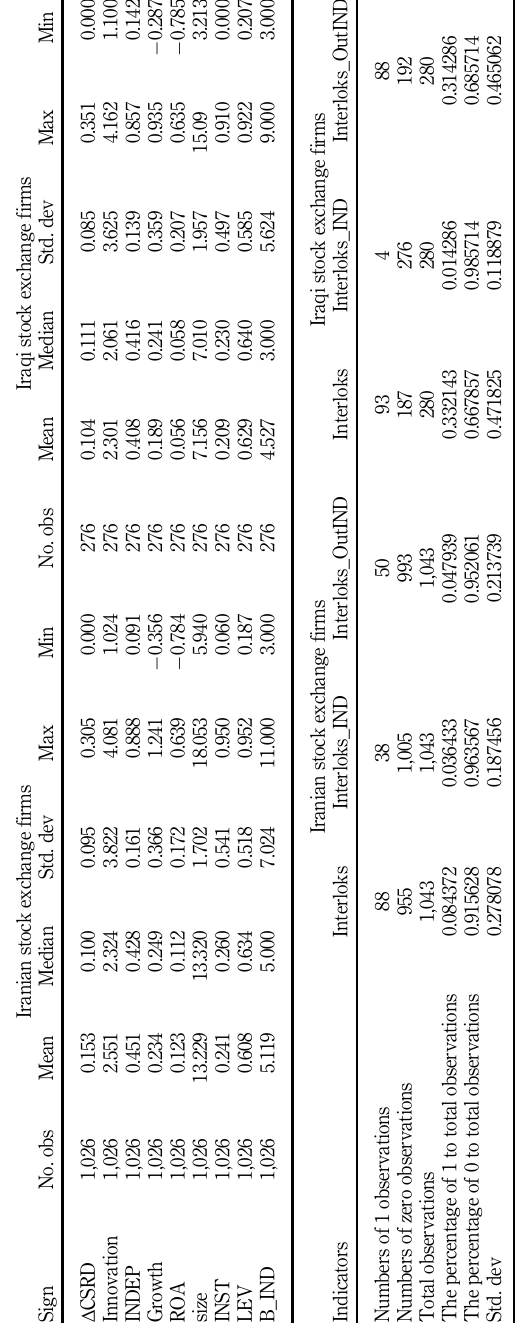
Table 1. Descriptivestatisticsof non-indicative